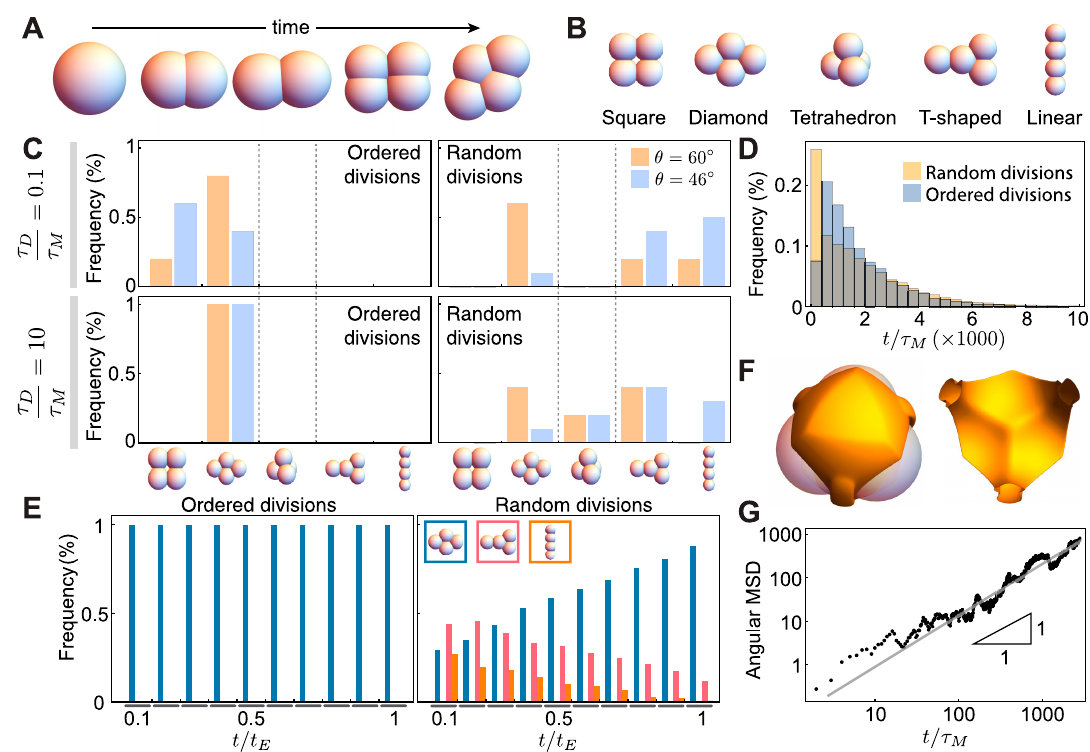
Fig 2. Packing configurations and dynamics of 4-cell stage unconfined embryos. A , Example of time evolution of cellular packings, showing how cell volume decreases by half upon division. B , Definition of possible topological arrangements at the 4-cell stage. C , Frequency of packing arrangements for slow and fast divisions ( τ / τ = 0.1, 10, respectively), different contact angles θ and both D M ordered and random division rules (n = 10 3 simulation runs for each parameter set). D , Histogram of the time to reach the equilibrium tetrahedral configuration (n = 10 5 simulation runs for each condition). E , Frequency of packing configurations as the system relaxes to equilibrium ( t E being the time to reach equilibrium) for both ordered (left) and random (right) divisions (n = 10 2 simulation runs for each condition). F , Top view (with cells) and cross section (without cells) showing the equipotential surface (orange tones) caused by three fixed cells on a fourth cell. G , Angular mean squared displacement (MSD) of a cell moving in the potential generated by three cells fixed in a triangle (n = 8 simulation runs), showing its diffusive nature (fit, gray line).